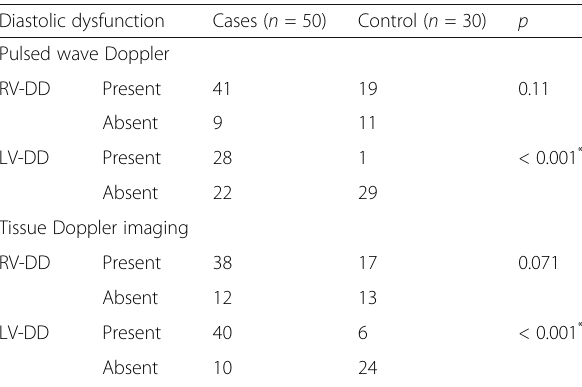
Table 3 Comparison between cases and controls as